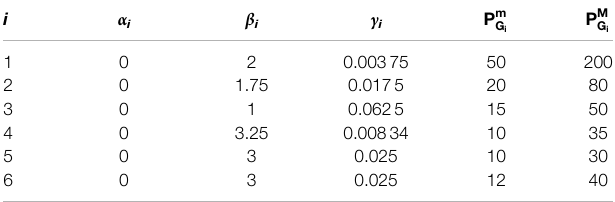
TABLE 1 | Parameters for IEEE-30 bus system.